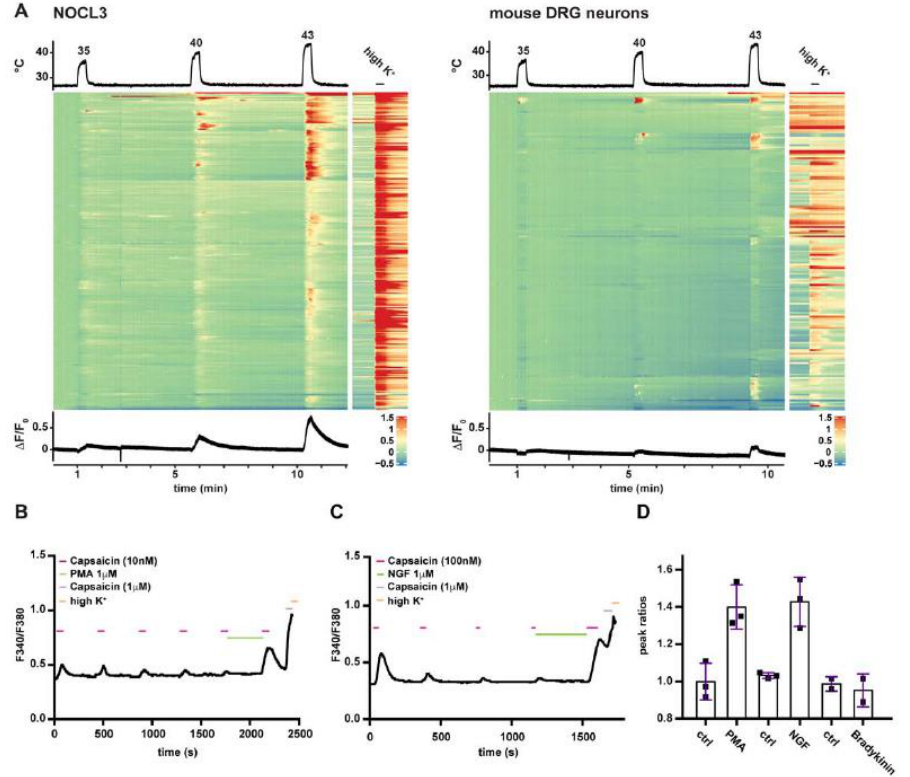
Figure 5. ( A ) Heatmaps of calcium imaging experiments challenging Cal520–loaded NOCL3 and mouse dorsal root ganglion (DRG) neurons with increasing temperatures from 35 °C to 43 °C and subsequently with high K + Ringer solution (to identify all neurons). Every row represents a single cell. Depicted is the ∆ F/F 0 ratio, using the baseline before the first stimulus as F 0 . The trace below the heat map shows the average response of all neurons (NOCL3 n = 248 cells; DRG n = 174). ( B ) Representative fluorescence ratios (340 nm/380 nm) obtained from one NOCL3 neuron loaded with Fura2 and stimulated with multiple pulses of capsaicin (10 nM). Incubation of cell with the phorbol ester PMA (1 uM) for 5 min results in sensitization leading to an increased response amplitude in response to a low concentration of capsaicin. Subsequent application of high K + ringer solution showed presence of all functional neurons. ( C ) Calcium response of a NOCL3 neuron stimulated repetitively with capsaicin (100 nM). Incubation with NGF (100 ng/mL) for 5 min sensitized the cell, resulting in an increased response to capsaicin. High K + ringer solution was added at the end to visualize functionality of the neuron. ( D ) Bar graphs represent the ratios between the peak response after and the peak response before application of inflammatory agents as indicated. Fraction of cells showing sensitization: PMA: 91% (753 of 823 cells); NGF: 28% (173 of 611 cells); bradykinin: 0% (0 of 319 cells).